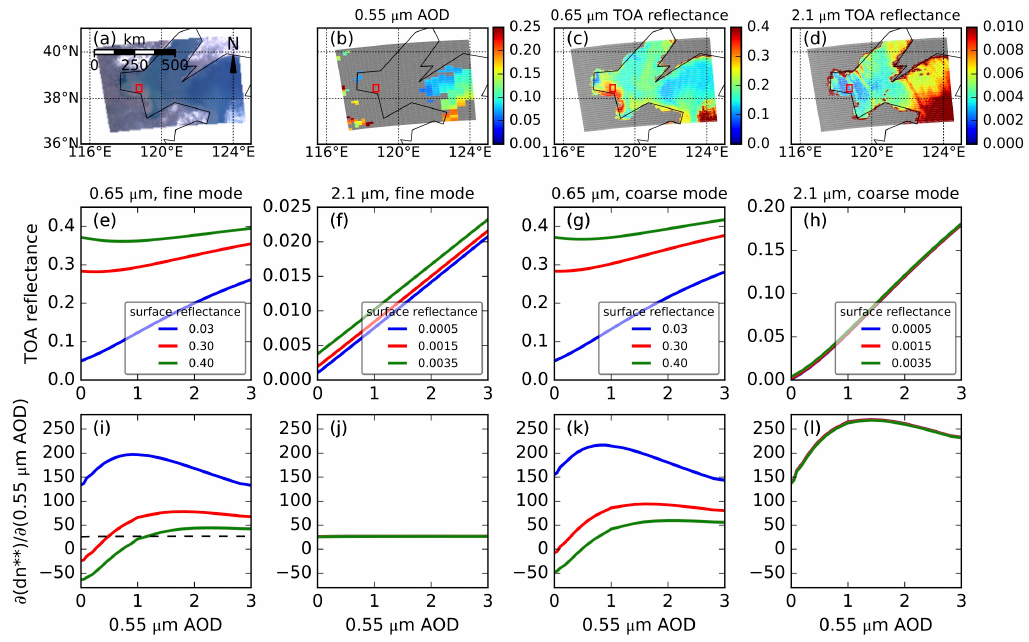
Figure 2. ( a – d ) are MODIS Aqua true color image, 0.55 µ m AOD, 0.65 µ m TOA reflectance, and 2.1 µ m Figure 2. ( a ), ( b ), ( c ), and ( d ) are MODIS Aqua true color image, 0.55 μ m AOD, 0.65 μ m TOA TOA reflectance at Bohai Sea, China on 23 February 2017, respectively. Red box is the region where reflectance, and 2.1 μ m TOA reflectance at Bohai Sea, China on Feb. 23, 2017, respectively. Red box is water is turbid and atmosphere is clean. ( e , f ) are simulation (solar zenith angle is 24 ◦ , view zenith the region where water is turbid and atmosphere is clean. ( e ) and ( f ) are simulation (solar zenith angle angle 54 ◦ , and relative azimuth angle 60 ◦ ) of 0.65 µ m and 2.1 µ m TOA reflectance with fine aerosol is 24°, view zenith angle 54°, and relative azimuth angle 60°) of 0.65 μ m and 2.1 μ m TOA reflectance model, respectively. ( g , h ) are similar to ( e , f ) but for coarse aerosol model. ( i , j ) are gradient of 0.65 µ m with fine aerosol model, respectively. ( g ) and ( h ) are similar to ( e ) and ( f ) but for coarse aerosol model. and 2.1 µ m MODIS digital signal (dn**) with respect to 0.55 µ m AOD with fine aerosol model. ( k , l ) ( i ) and ( j ) are gradient of 0.65 μ m and 2.1 μ m MODIS digital signal (dn**) with respect to 0.55 μ m are similar to ( i , j ) but for coarse aerosol model. Values in the legends are surface reflectance used to AOD with fine aerosol model. ( k ) and ( l ) are similar to ( i ) and ( j ) but for coarse aerosol model. Values simulate TOA reflectance at corresponding in the legends are surface reflectance used to simulate TOA reflectance at corresponding wavelength.